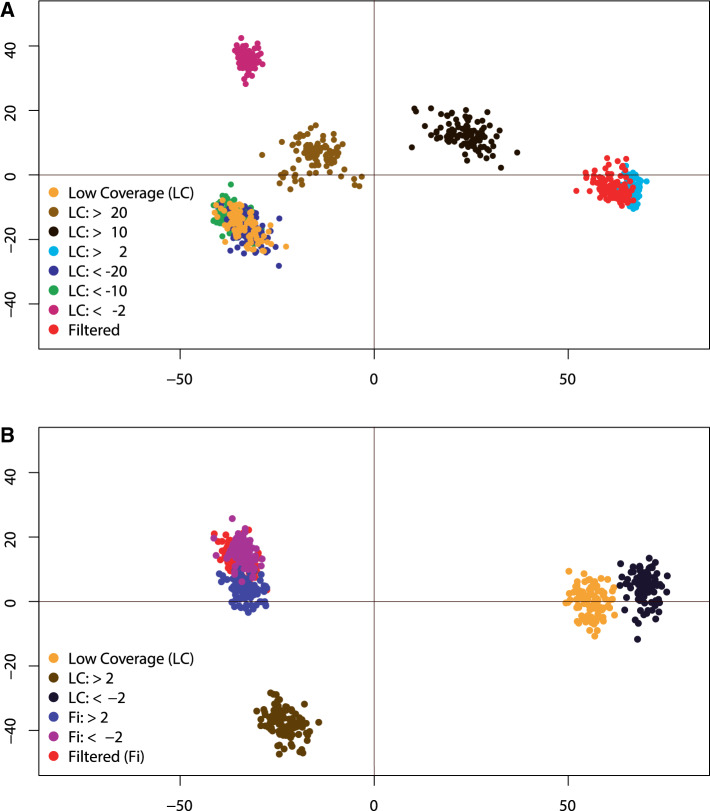
Multidimensional scaling of Robinson–Foulds distances among 100 bootstrap trees with differing levels of outlier sites or loci excluded. (A) Compares distances among Filtered and Low Coverage trees where outlier sites have been removed at different increments. Outlier sites were excluded in the Low Coverage alignment using Δ site-wise log-likelihood (Δ s-lk) thresholds of >20, >10, >2, <−2, <−10, and <−20. (B) The distances among trees produced from the subclade outlier analyses. Shown is a comparison of the Low Coverage and Filtered trees with topologies estimated with outlier loci excluded using Δ locus-wise log-likelihood (Δ l-lk) thresholds of >2 and <−2.